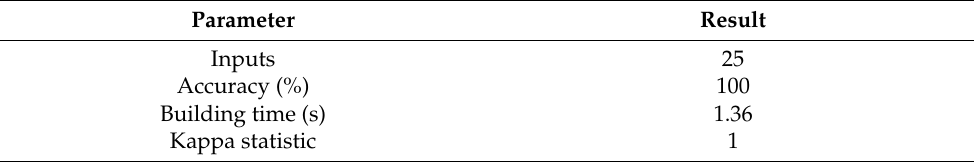
Table 2. Parameters and accuracy of the neural